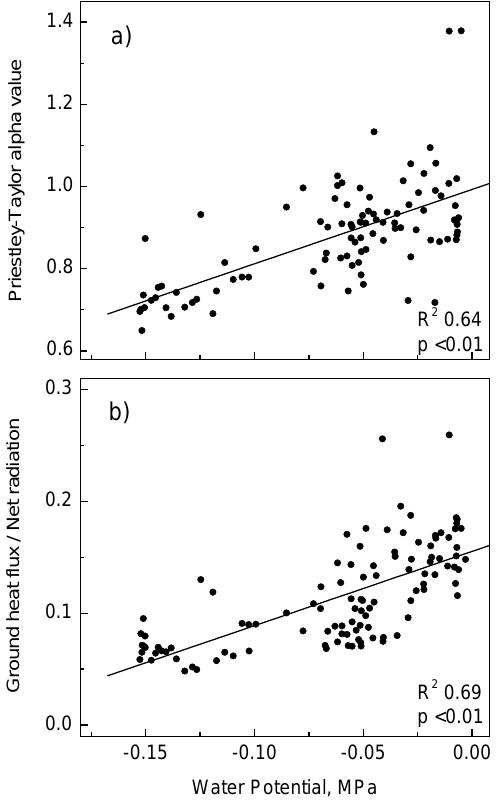
Fig. 4. The rate of evapotranspiration in relation to (a) the equi- librium rate (Priestley-Taylor α ) and (b) near-surface soil moisture at the BE site. The partitioning of net radiation, R n , into ground heat flux is linearly correlated to near-surface soil moisture (10cm depth). The results represents mean midday values at the BE